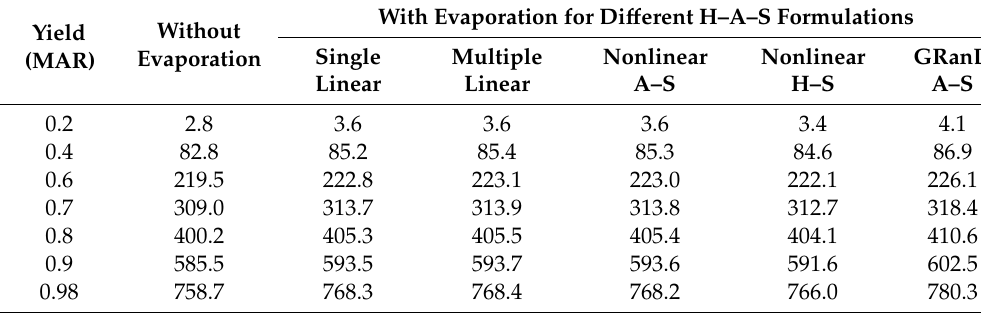
Table 4. Bhakra reservoir active storage-capacity estimates (10 6 m 3 ) .